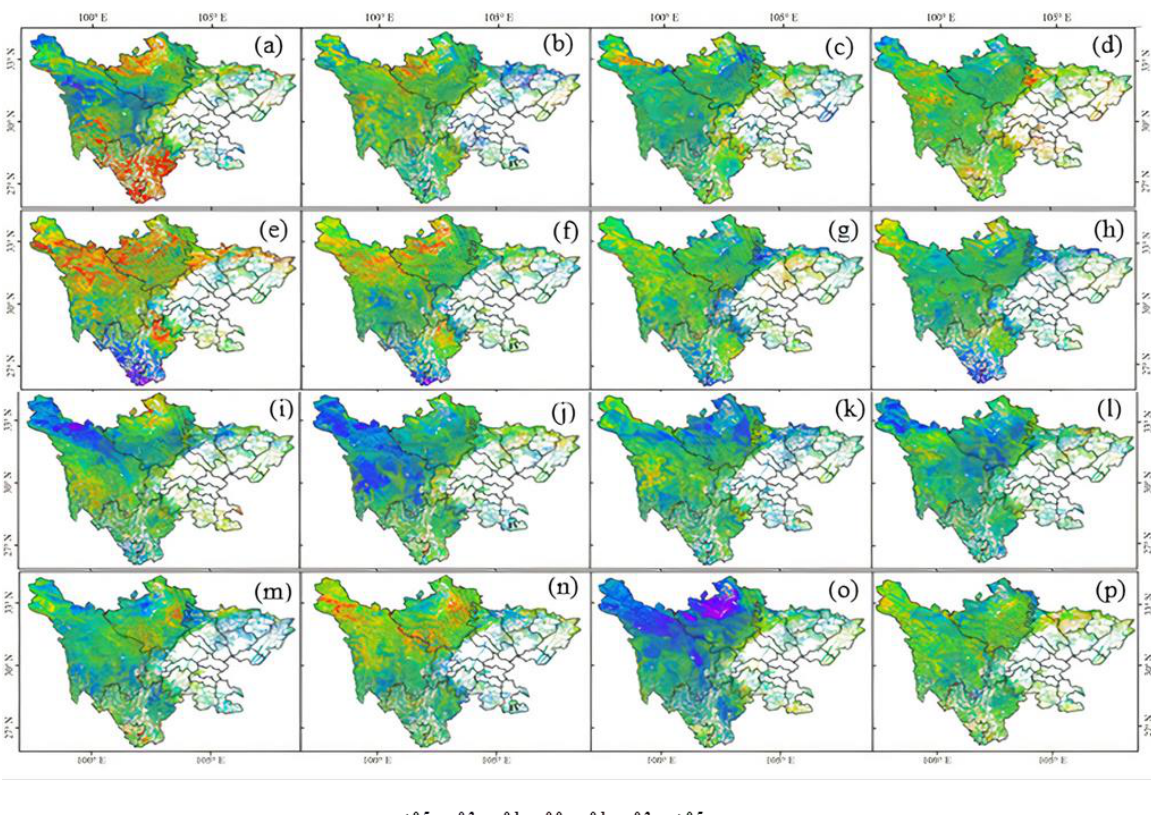
Figure 8. Partial correlation analysis between SOS and EOS and precipitation and temperature over the four seasons with significance at the p = 0.05 level. Partial correlation between SOS and precipitation in ( a ) spring, ( b ) summer, ( c ) autumn, ( d ) winter; partial correlation between SOS and temperature in ( e ) spring, ( f ) summer, ( g ) autumn, ( h ) winter; partial correlation between EOS and precipitation in ( i ) spring, ( j ) summer, ( k ) autumn, ( l ) winter; partial correlation between EOS and temperature in ( m ) spring, ( n ) summer, ( o ) autumn, ( p )